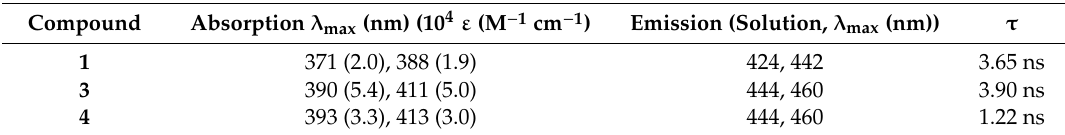
Table 1. Absorption and emission data of free ligand 1 and the compounds 3 and 4 in dichloromethane at 1 × 10 − 5 M. ( λ exc = 345